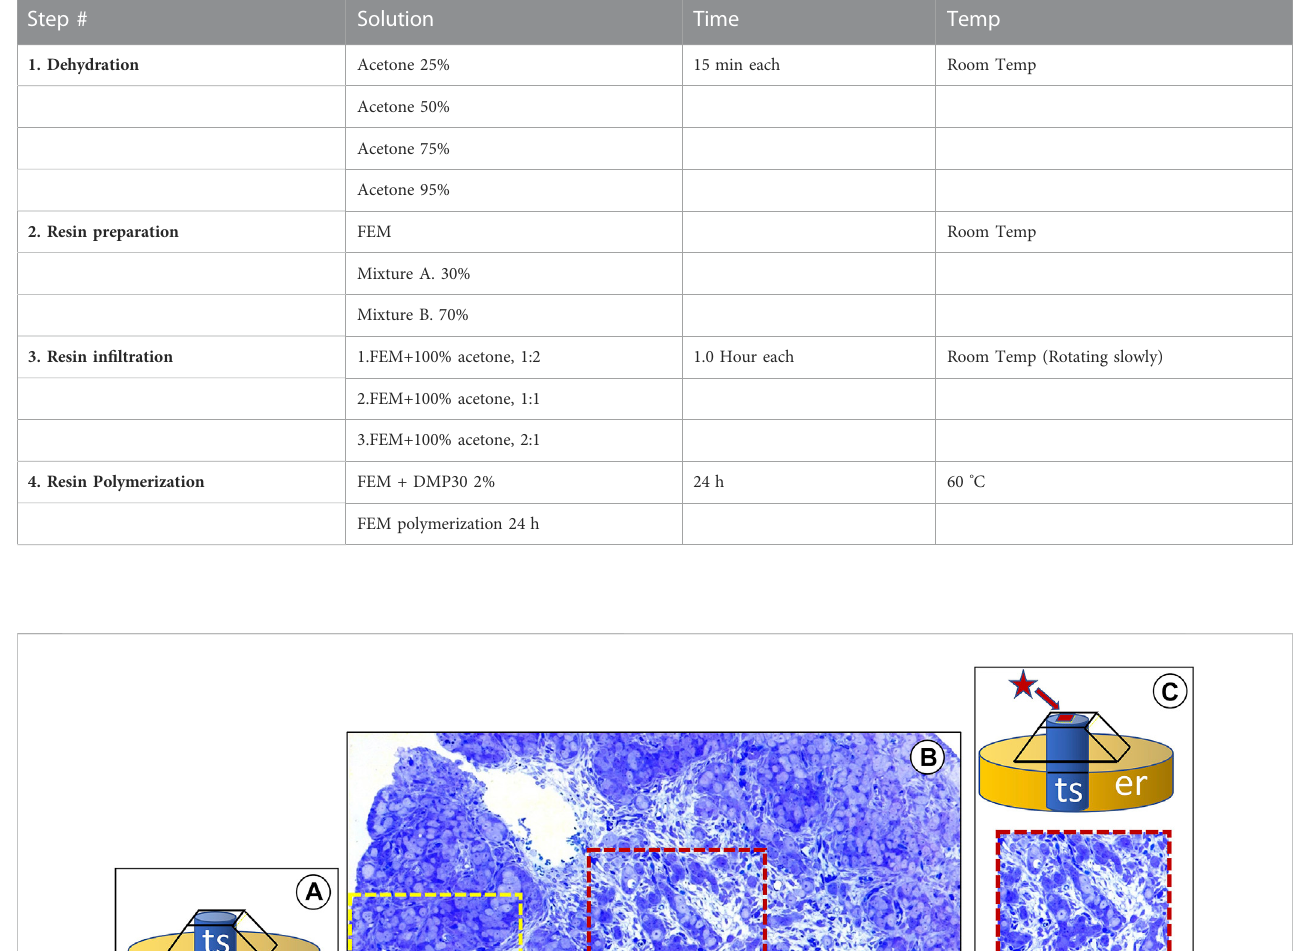
TABLE 1 FEM: Final embedding mixture. Mixture A: Epon 812, 62 mL + dodecenyl succinic anhydride (DDSA), 100 mL. Mixture B: Epon 812, 100 mL + methyl nadic anhydride (MNA), 89 mL. Step #